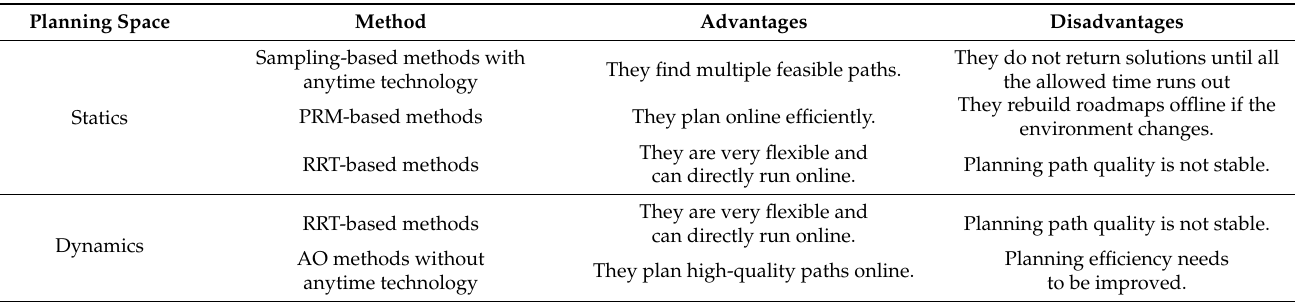
Table 1. A summary of sampling-based